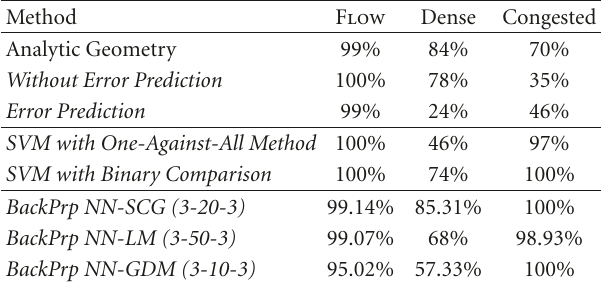
Table 2: Estimation Performance of Our Model for Each Tra ffi c condition.